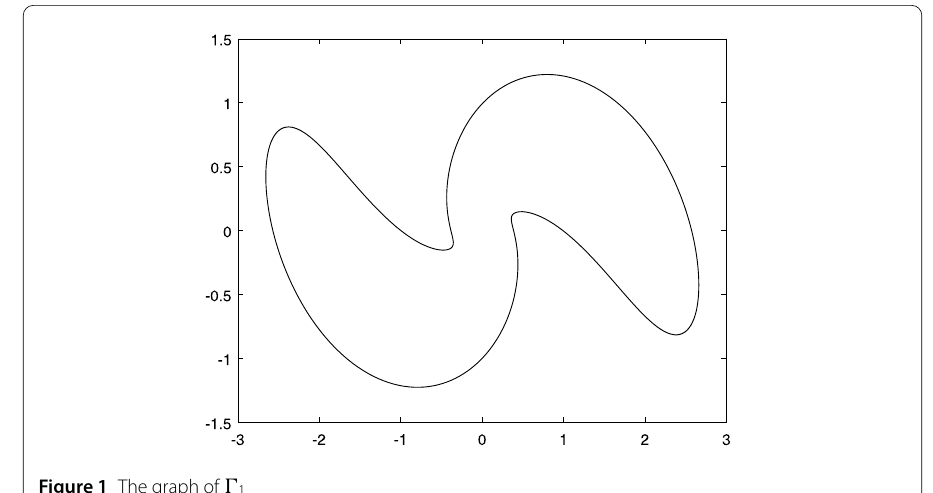
Figure 1 The graph of (cid:11)